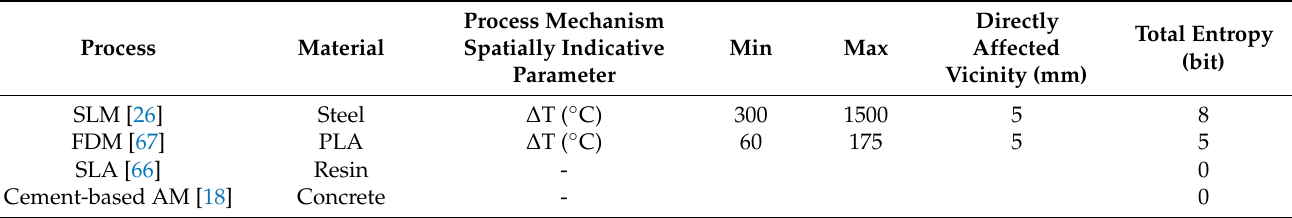
Table 5. Process-mechanism spatial